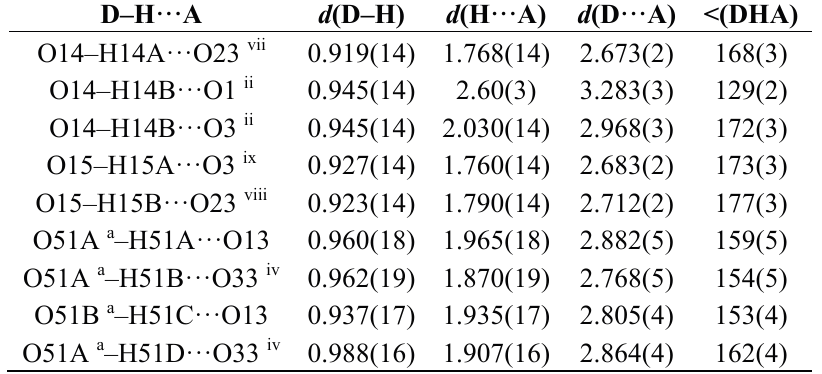
Table 3. Hydrogen bond geometry (Å, °) in the crystal structure of complex 2